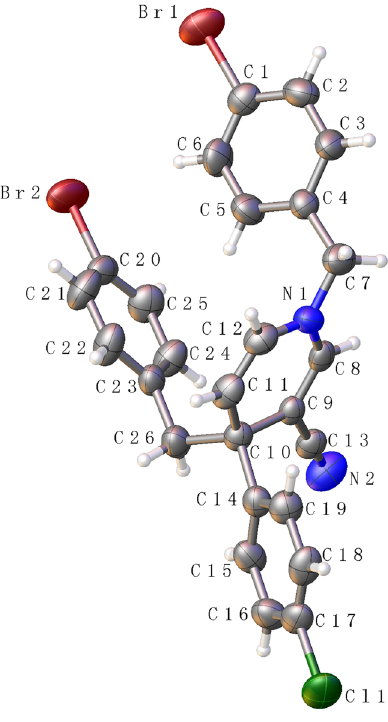
Table  : Data collection and